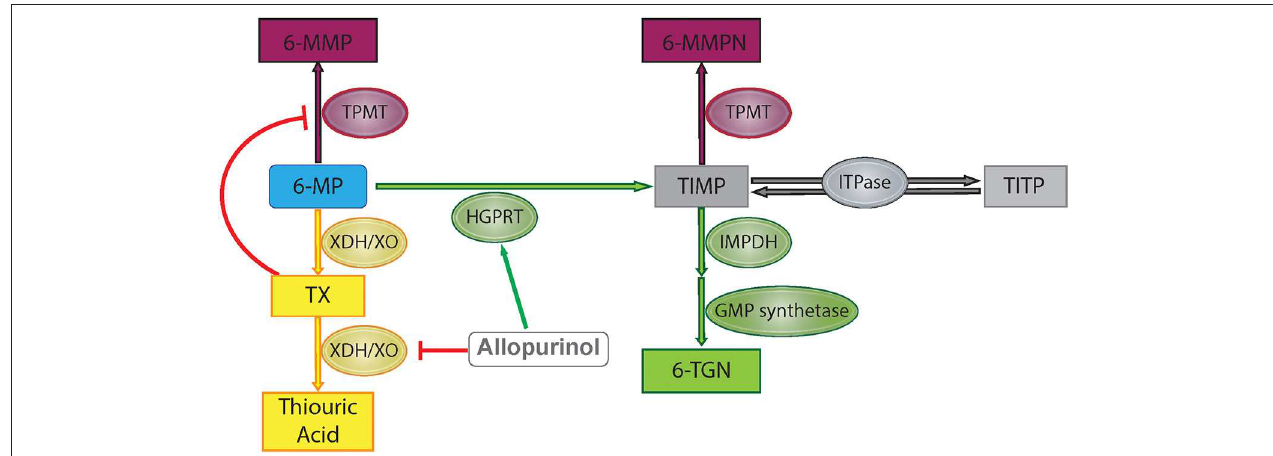
FIGURE 1 | 6-Mercaptopurine metabolism with proposed allopurinol mechanisms of action. Green represents HGPRT pathway, yellow represents XO pathway, and maroon represents methylation pathway. 6-MP, 6-mercaptopurine; 6-MMP, 6-methylmercaptopurine; 6-MMPN, 6-methylmercaptopurine nucleotides; TIMP, thio-inosine monophosphate; TITP, thio-inosine triphosphate; TX, thioxanthine; 6-TGN, 6-thioguanine nucleotide; TPMT, thiopurine methyltransferase; HGPRT, hypoxanthine-guanine phosphoribosyltransferase; XDH/XO, xanthine dehydrogenase/xanthine oxidase; IMPDH, inosine monosphosphate dehydrogenase; GMP, guanosine monophosphate; ITPase, inosine triphosphatase